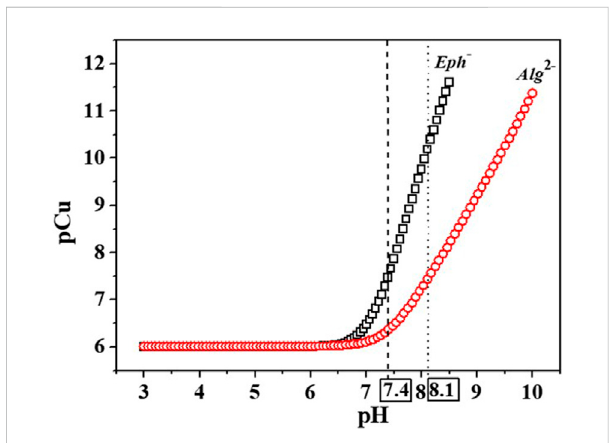
FIGURE 9 pCu values trend calculated vs. pH for the Cu 2+ / Eph- and Cu 2+ / Alg 2- systems. pCu = -log [Cu] free with c cu2+ = 0.001 mmol dm − 3 and